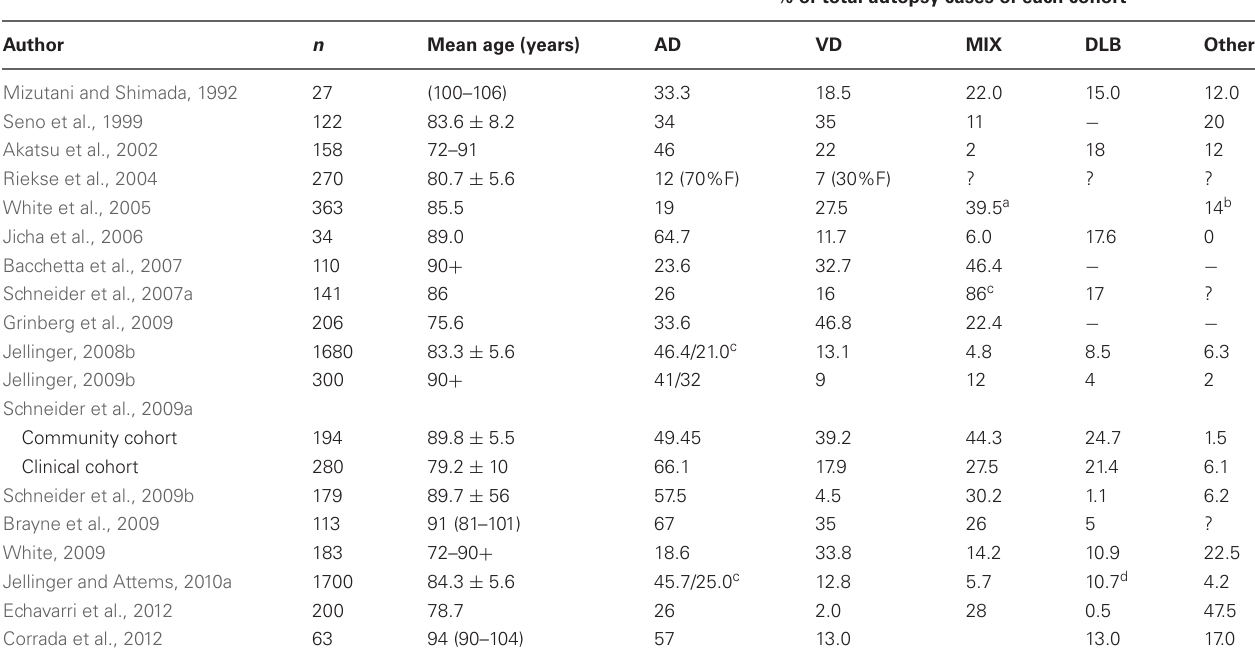
Table 5 | Types of dementia in oldest-old subjects— autopsies